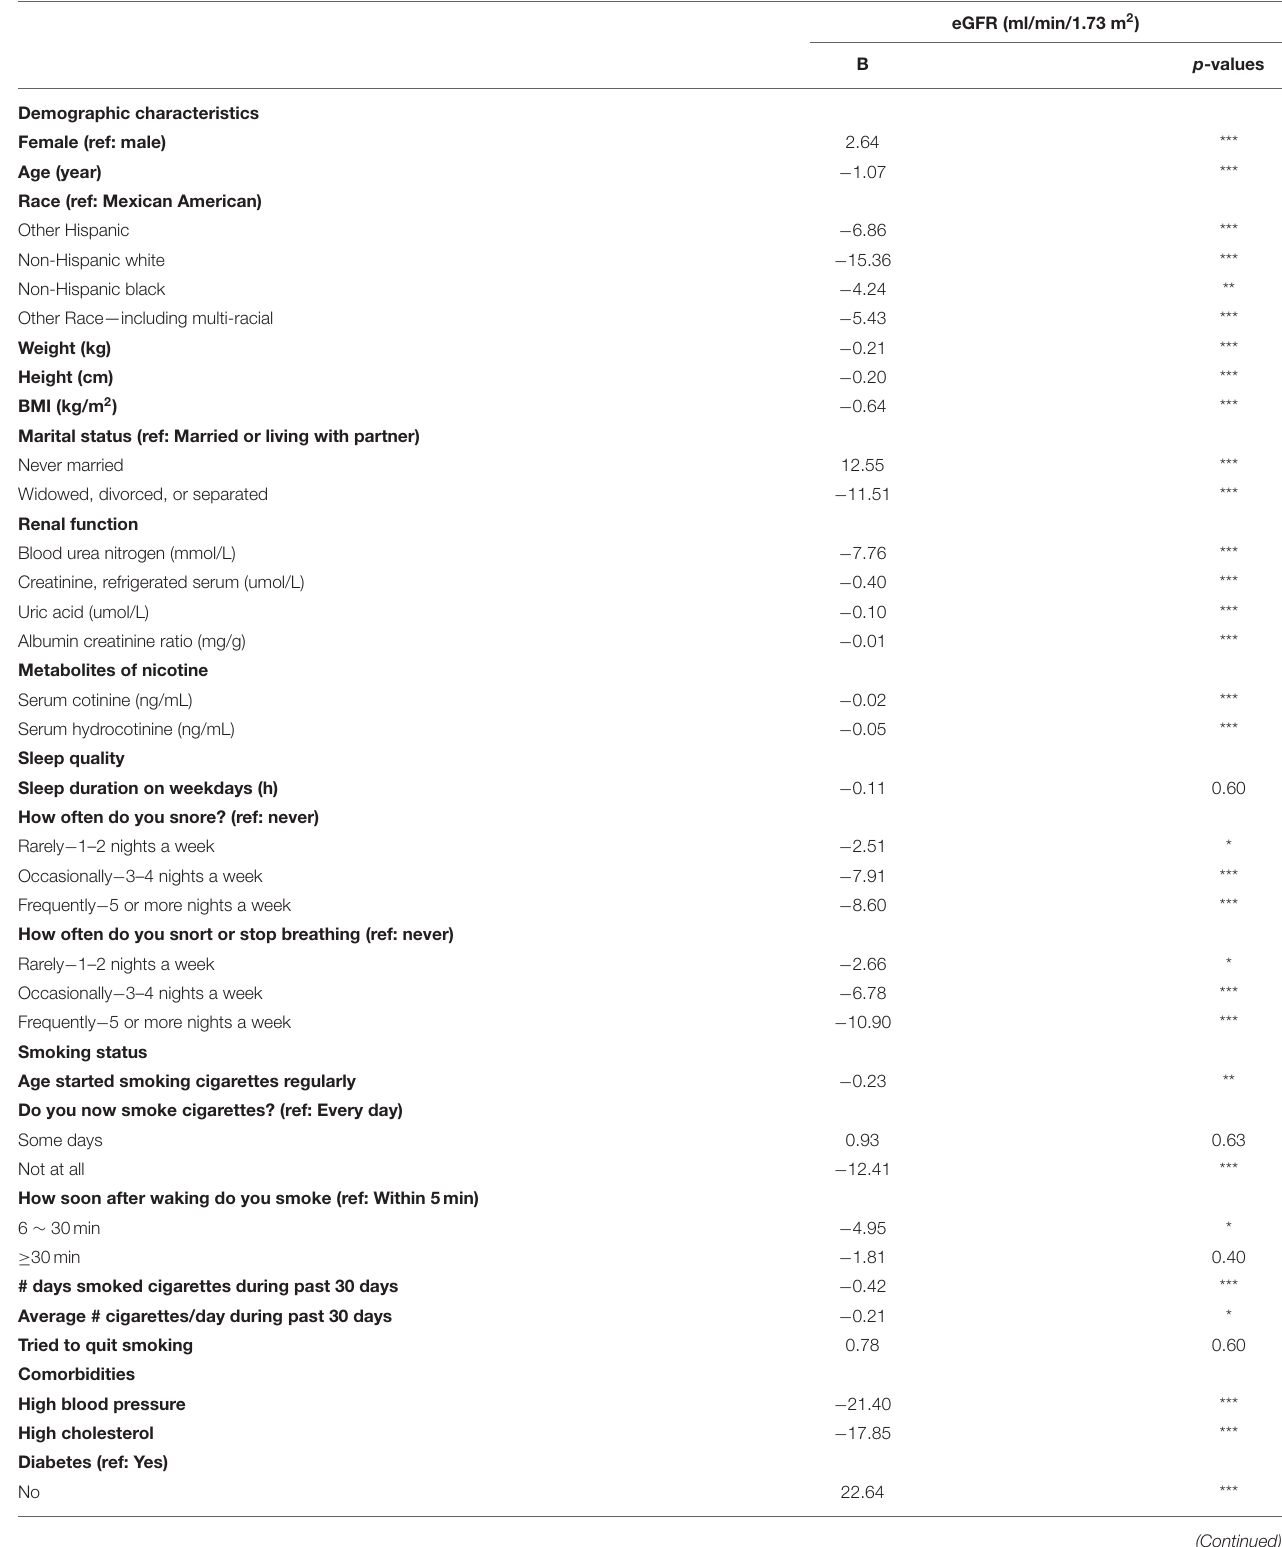
eGFR (ml/min/1.73 m 2 ) B p -values